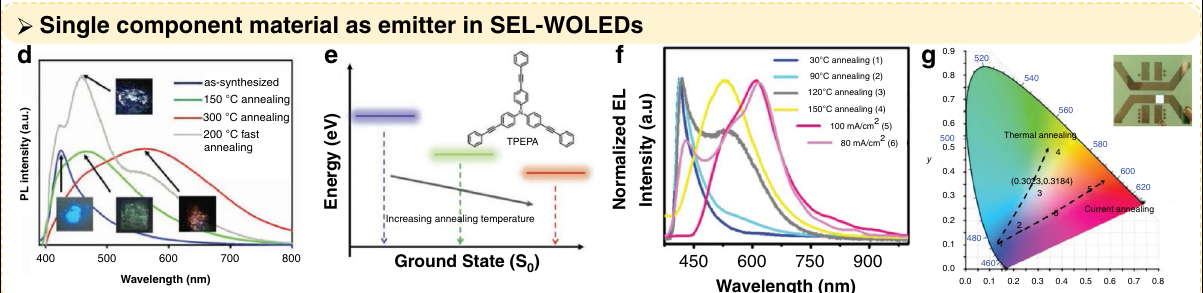
Zeng Q. et al. 24 . By blade coating, the hole transport layer (PVK), the light-emitting layer (mixed R/G/B QDs), and the electron-transport layer (ZnO) were deposited sequentially (Fig. 7h, i). As shown in Fig. 7j, k, the device performed white light with a CIE coordinate of (0.33, 0.36) and a high CRI of 90 at a very high luminance (>10,000 cd m − 2 @ 7 V). More noteworthy is that a 3 × 8- cm 2 SEL – WQLED with homogenous white light emission was demonstrated by a blade-coating process, showing